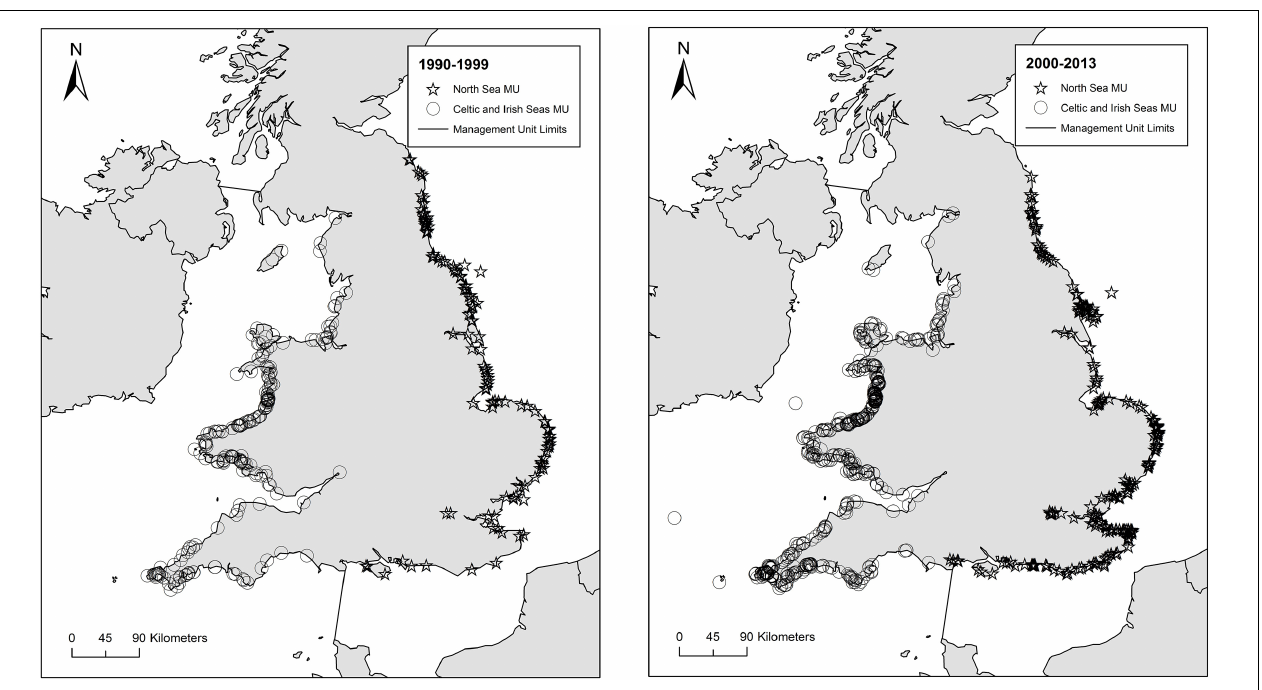
FIGURE 1 | Locations of stranded and bycaught harbor porpoises from the North Sea MU (stars) and Celtic and Irish Seas MU (circles) between (a) 1990 and 1999 and (b) 2000 and 2013. See associated text for n values. Maps were created with ArcGIS version 10.3.1©2015